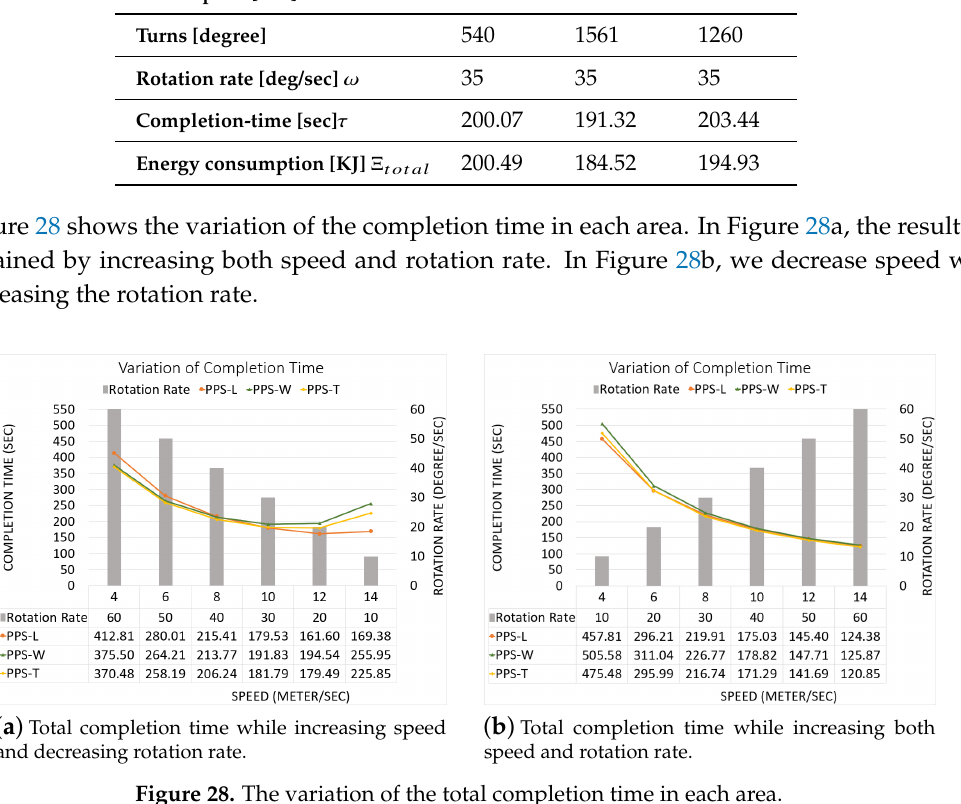
Figure 28. The variation of the total completion time in each